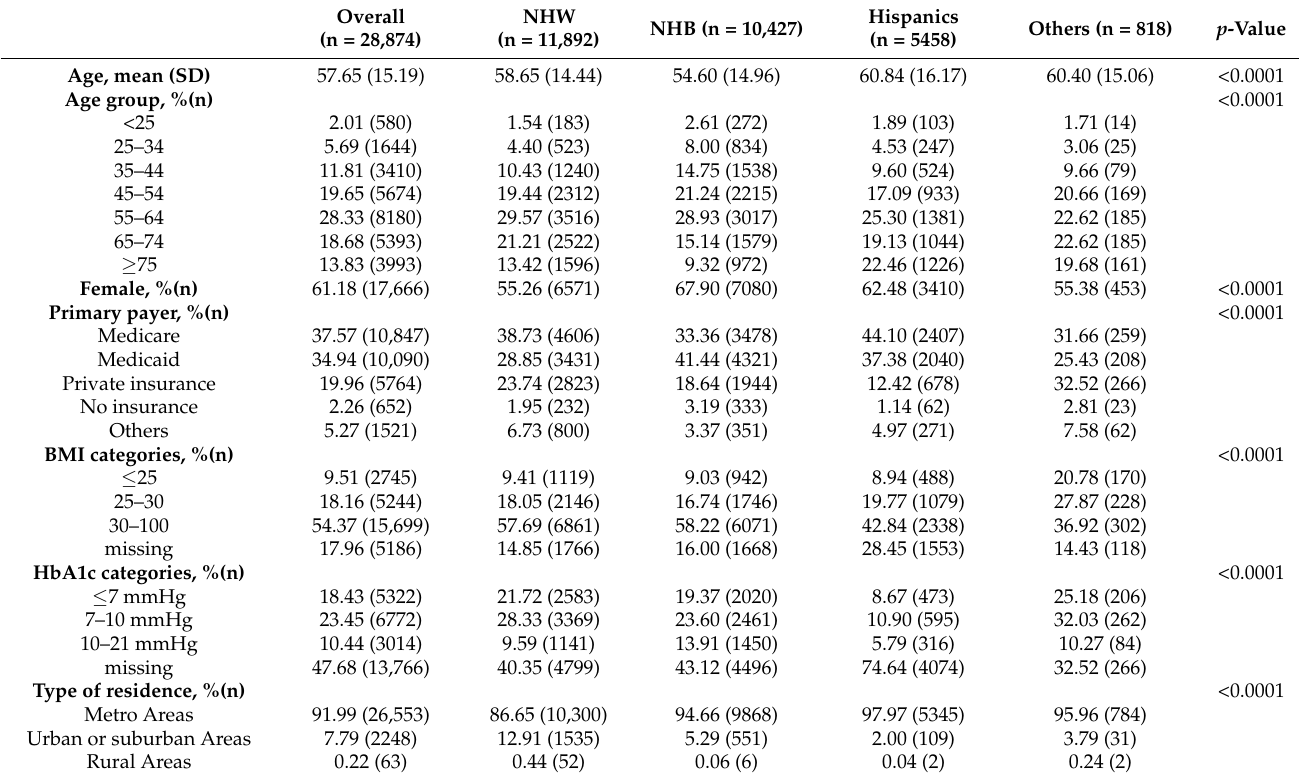
Table 2. Patient Characteristics, by